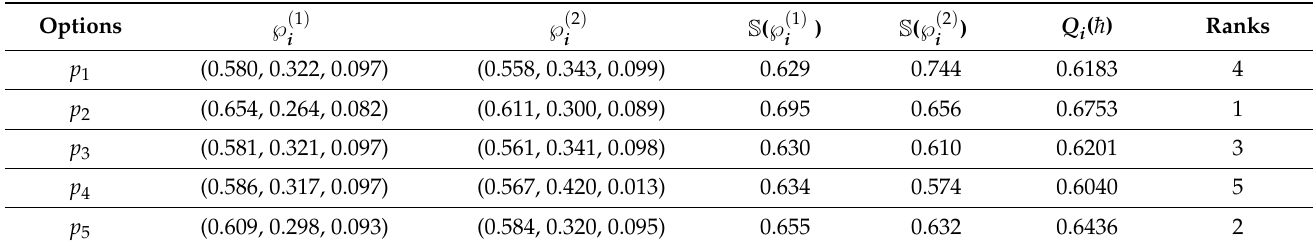
Table A10. The IF-WASPAS method for prioritizing the BESSs.